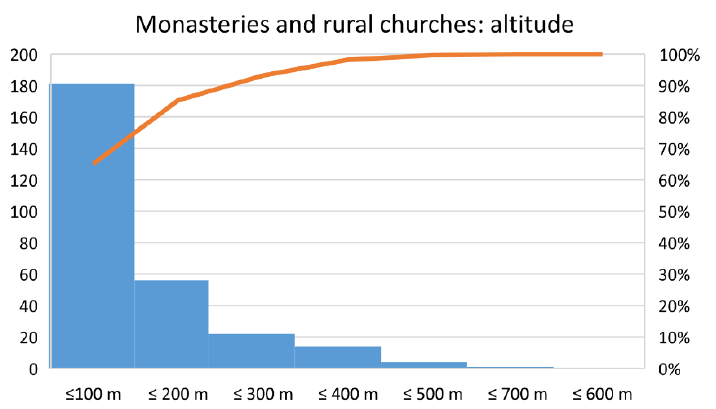
Figure 9. The altitude of monastic and rural churches on Paros (data and graph by the author).